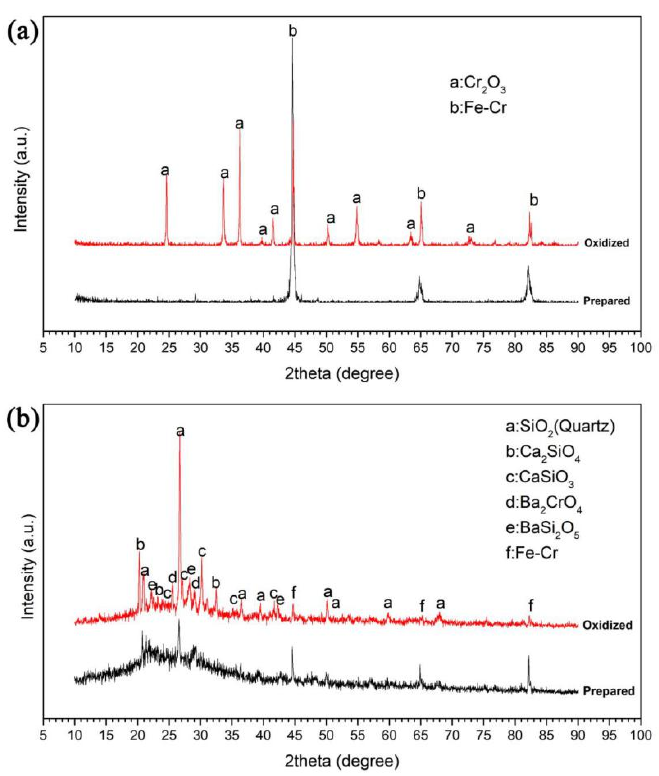
Figure 4. XRD patterns of as-prepared MSS without ( a ) and with ( b ) GCC and oxidized for 100 h at 650 °C.